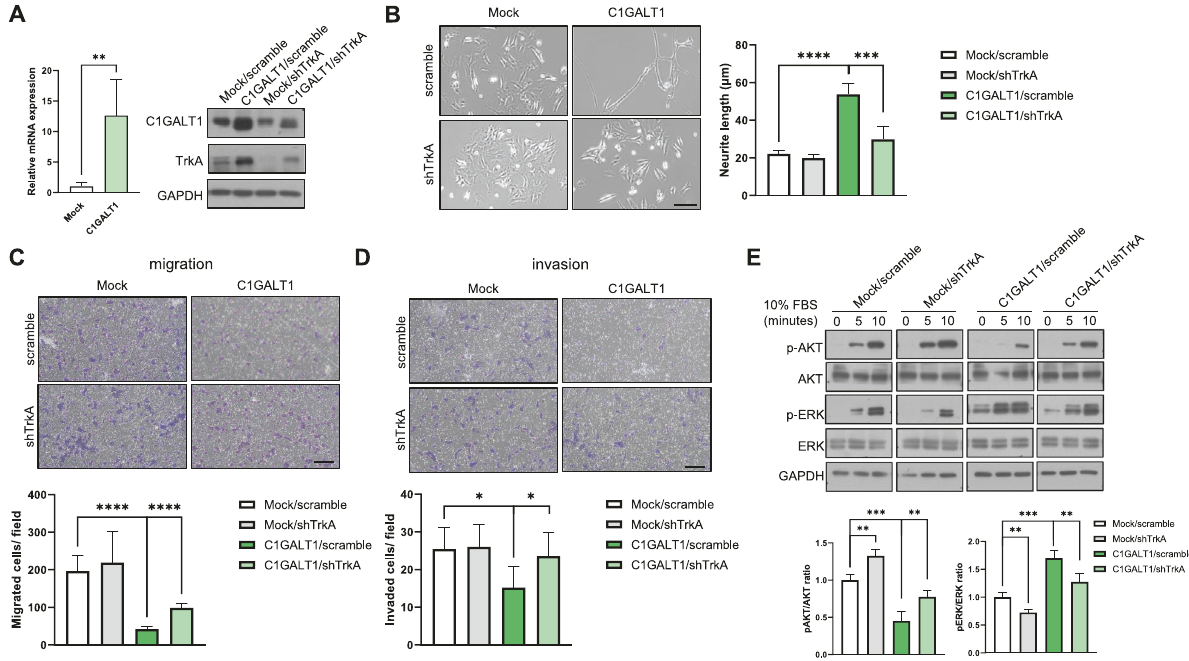
Fig. 4 Overexpression of C1GALT1 mediates antitumor effects on NB cells through TrkA. A qRT-PCR analysis showed the mRNA expression levels of C1GALT1 in mock and C1GALT1-overexpressing SK-N-SH cells. Western blot analysis showed the protein expression levels of C1GALT1, TrkA and GAPDH in SK-N-SH transfectants infected with shTrkA or negative control lentivirus. B – D C1GALT1 overexpression- mediated antitumor effects were attenuated by silencing TrkA. B Representative images showed neurite outgrowth of SK-N-SH transfectants infected with shTrkA or negative control lentivirus for 3 d photographed under a phase-contrast microscope. Scale bar indicates 100 μ m. Arrowheads indicate neurite outgrowth. Bars represent the mean of three independent experiments. C Representative pictures showed the ability of transwell migration in SK-N-SH transfectants infected with shTrkA or negative control lentivirus. Bars (lower panel) represent the mean number of migrated cells ( n = 3, scale bar indicates 100 μ m). D Representative pictures showed Matrigel invasion assay in SK-N-SH transfectants infected with shTrkA or negative control lentivirus. Bars (lower panel) represent the mean number of invaded cells ( n = 3, scale bar indicates 100 μ m). E C1GALT1 overexpression-mediated changes in AKT and ERK phosphorylation were reversed by silencing TrkA. Serum- starved cells were reintroduced with 10% FBS for different times as indicated. Western blots show the expression of AKT, p-AKT, ERK, p-ERK, C1GALT1, and GAPDH ( n = 3). The bar diagrams of the ratios of p-AKT/total AKT and p-ERK/total ERK were shown in the right panel. * p < 0.05, ** p < 0.01, *** p < 0.001, **** p <